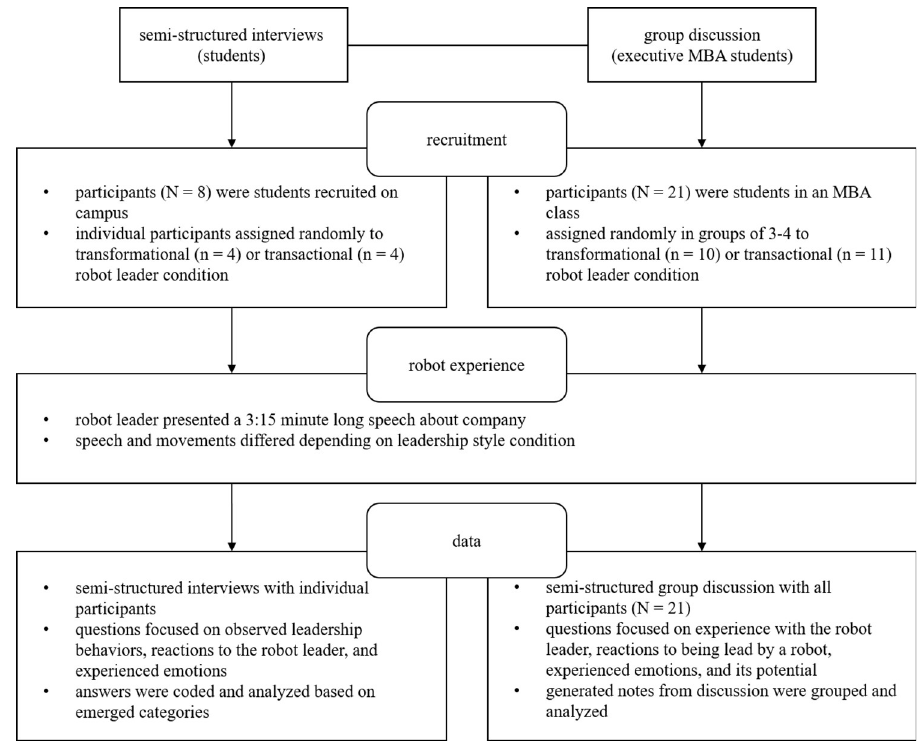
Fig 1. Overview of the procedures for both